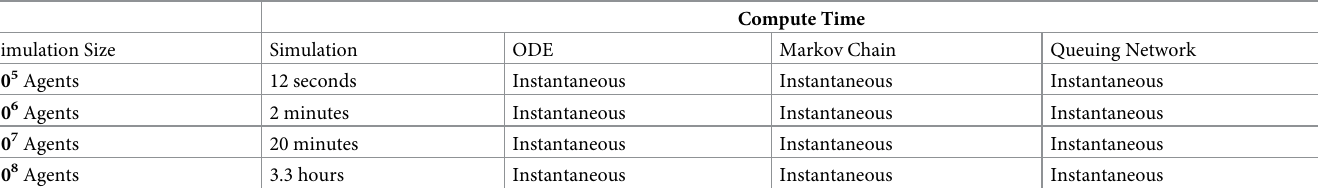
Table 3. Scaling of Compute Time with